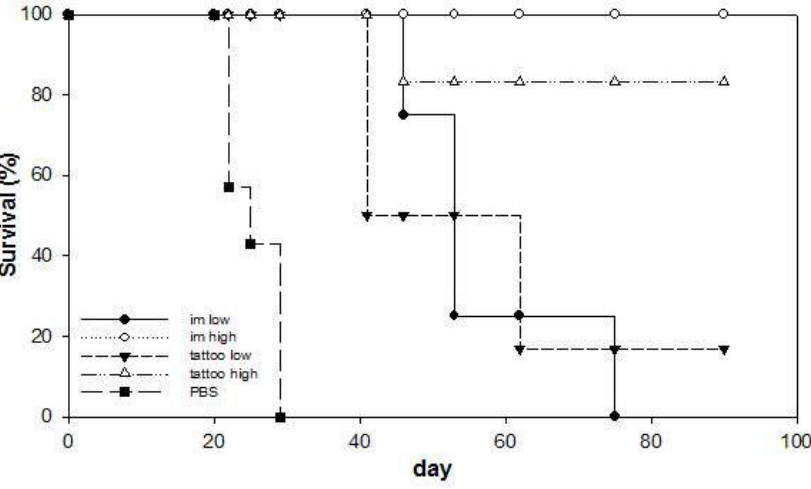
Figure 3. SFVeE6,7 tattoo immunizations result in high therapeutic efficacy. Mice